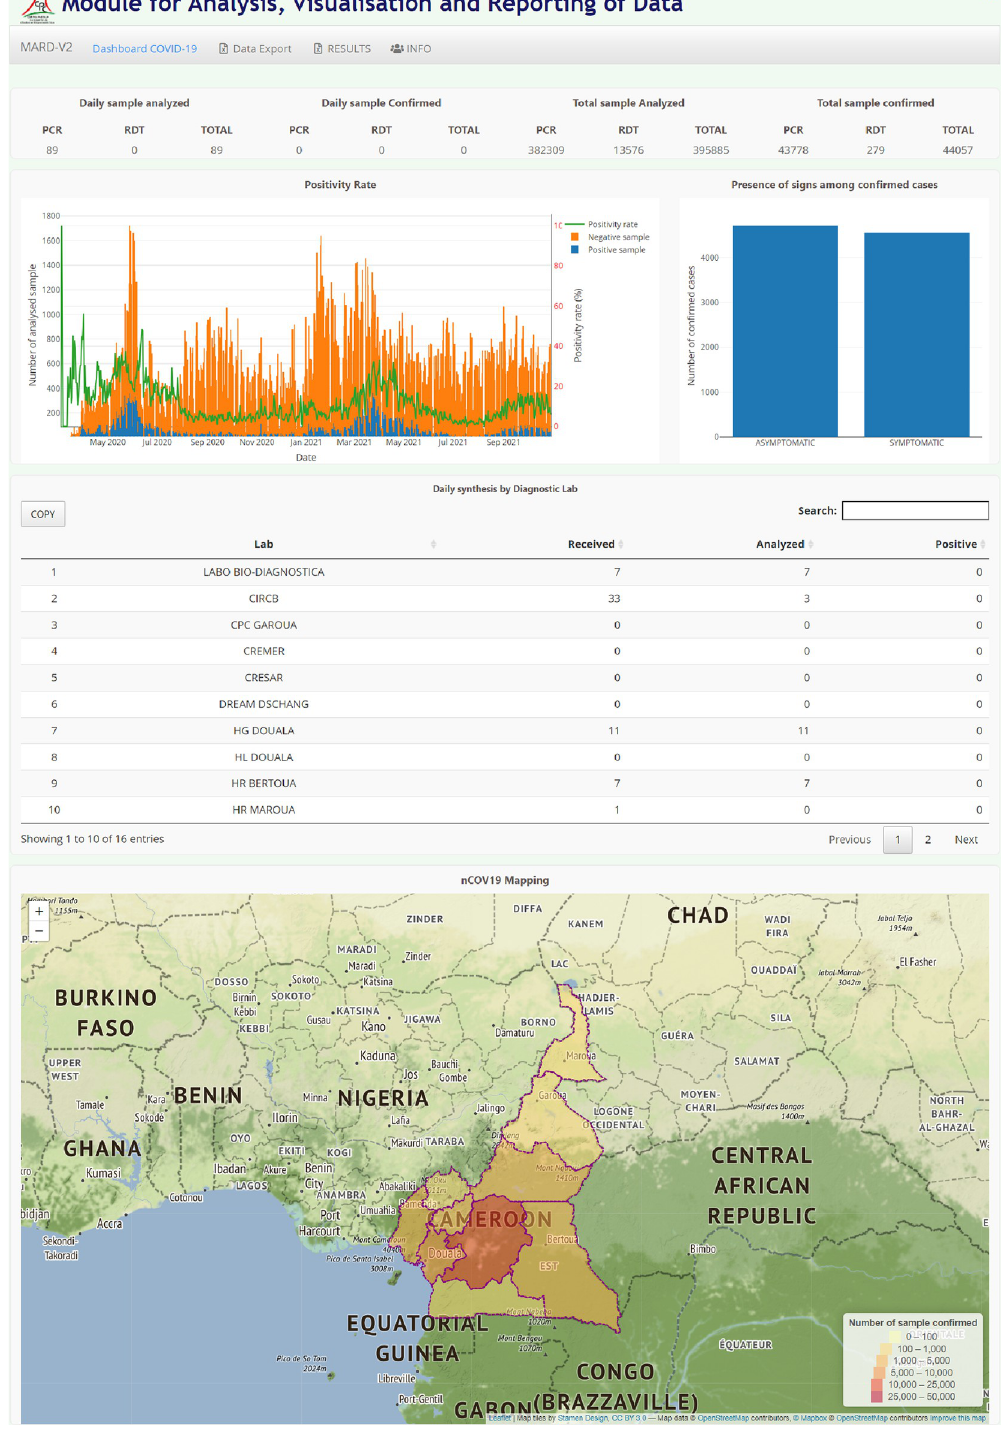
Fig 4. The PlaCARD real time dashboard at National level. a) Basemap source: http://maps.stamen.com/terrain/? request=GetCapabilities&service=WMTS&version=1.0.0#4/19.15/5.27 . b) Link to the term of use basemap: http://maps. stamen.com/#terrain/4/19.15/5.27 .